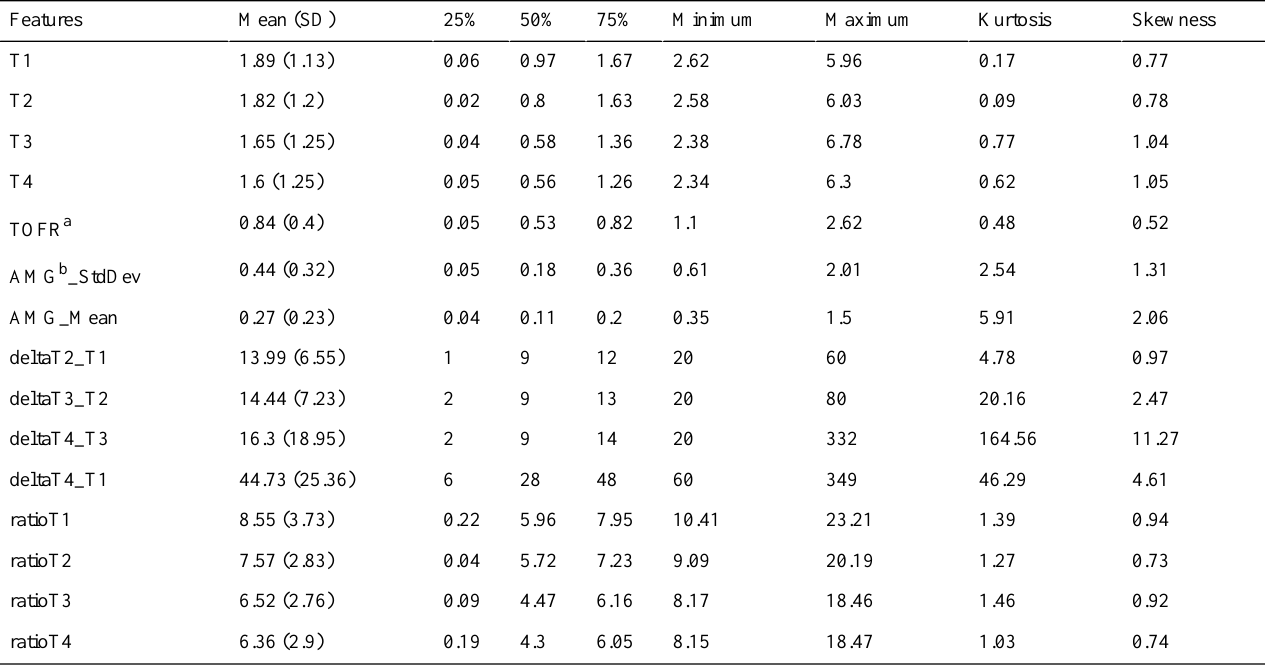
Table 3. Descriptive statistics of basic features and engineered